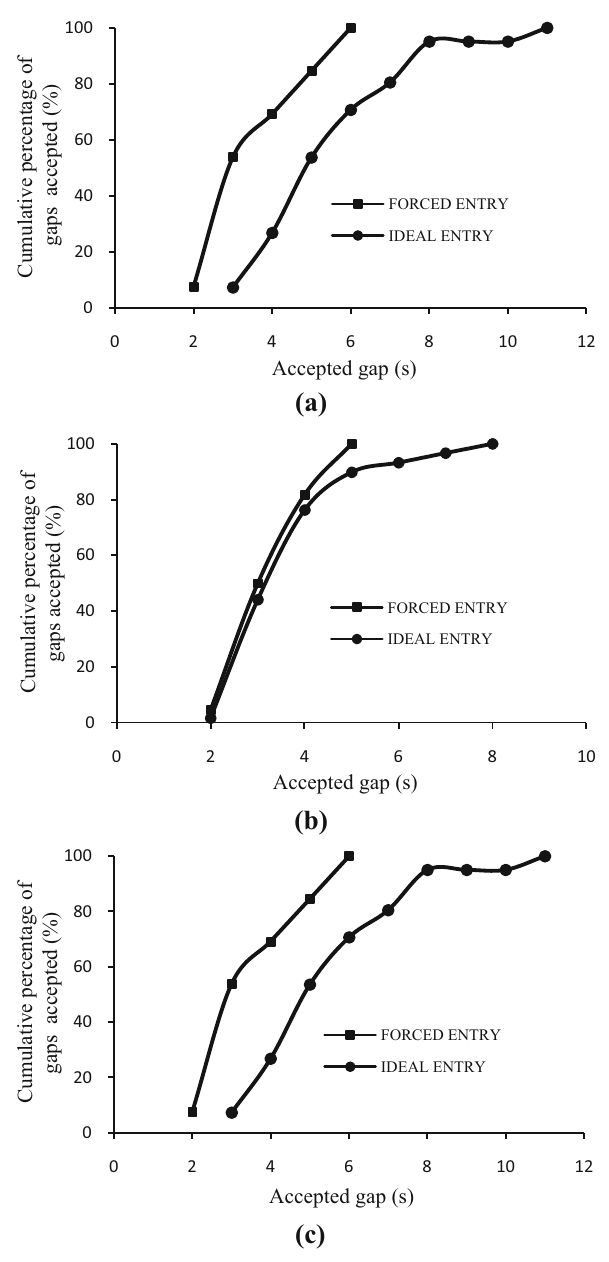
Fig. 9 Cumulative percentage of gap acceptance for aggressive and non-aggressive drivers of a intersection A, b intersection B